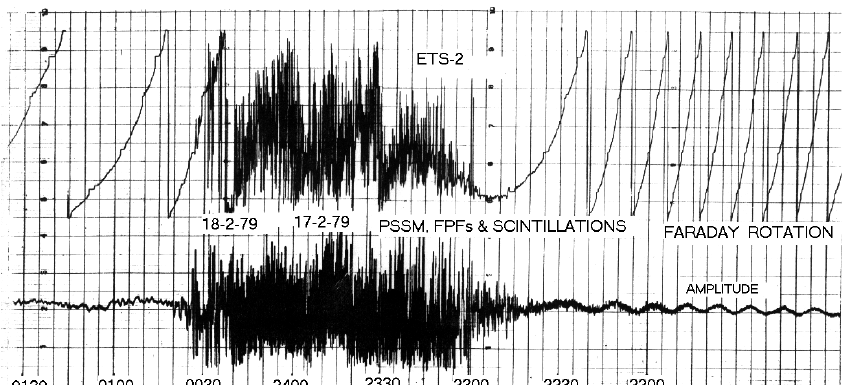
Fig. 1. Faraday rotation and ampli- tude records showing PSSM, scintilla- tions and FPFs